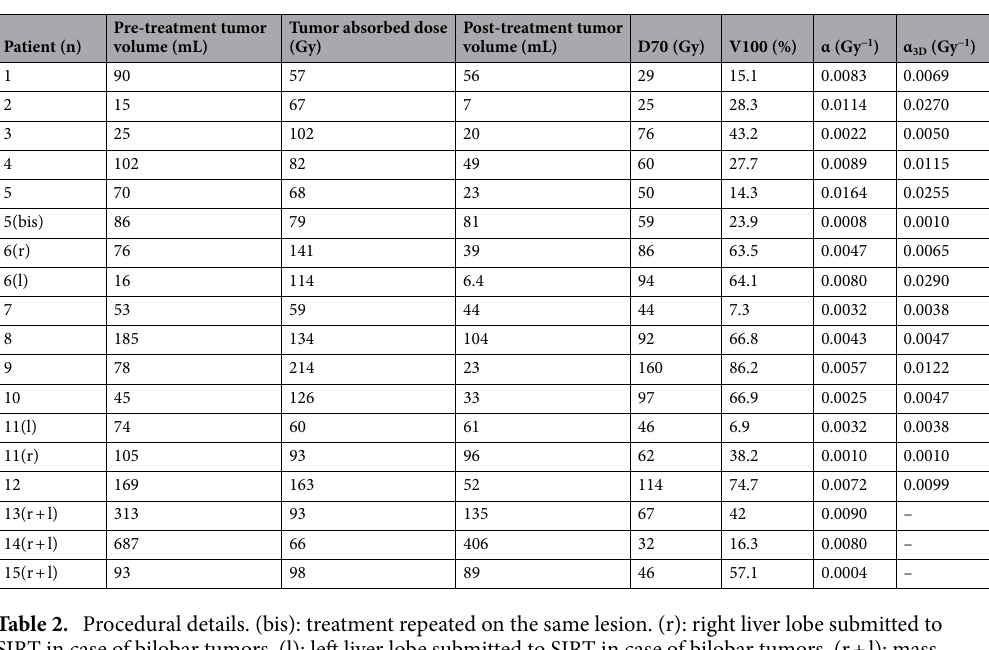
At first follow-up, evaluation of radiological response showed 3 (20%) patients with partial response (PR), 10 (67%) with stable disease (SD) and 2 (13%) with progressive disease (PD). At 3 months, 3 (20%) patients showed PR, 6 (40%) SD and 6 (40%) PD. Median TTP was 7.3 months (95% CI 3.2–18.0 months). Table 3 shows the results of the univariate and multivariate Cox’s proportional hazards model analysis for some tumor-related continuous variables. Tumor burden, D70 and V100 had no effects on TTP. Multivariate analysis showed a statistically significant negative effect of tumor volume on TTP (p < 0.03) as well as a positive effect of tumor absorbed dose on TTP (p = 0.05). The α (Eq. 4) and α 3D (Eq. 5) values were 0.005 Gy −1 (95% CI 0.004–0.008) and 0.007 Gy −1 (95% CI 0.005–0.015), respectively. A significant linear relationship (r 2 = 0.69; p = 0.0001) was obtained between these two parameters showing α 3D values higher than α values with a positive slope of about 1.8 and an intercept close to 0 (Fig. 3). No statistically significant difference in α and α 3D values was found comparing patients submitted to SIRT alone to patients treated with SIRT plus chemotherapy (Table 4). Following the RECIST 1.1 criteria, radiological PR corresponds to the reduction ≥ 30% of the diameter of the lesion. Considering the approximation of spherical volumes, this corresponds to a final tumor volume M f ≤ 0.34 M